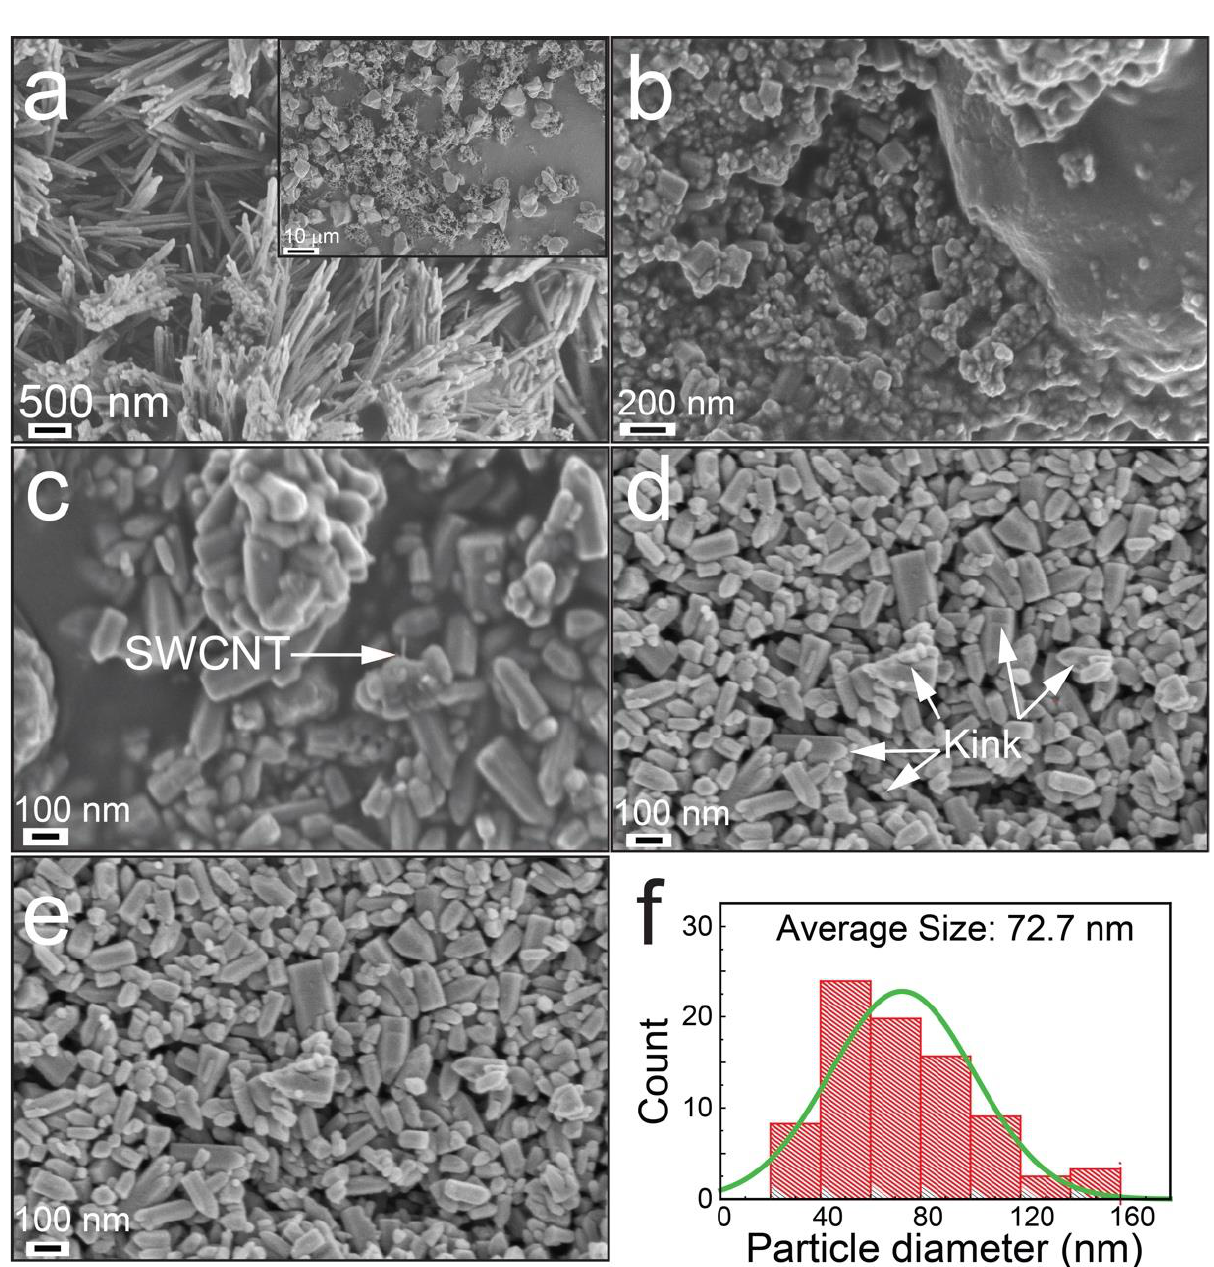
Figure 2. FE-SEM images: ( a ) pristine ZnO, ( b ) ZSC1, and ( c ) ZSC2. ( d ) Micrograph showing defects developed on the surface of the ZSC3 heteronanocomposite. ( e ) Micrograph of ZSC3. ( f ) Histogram of the particle size distribution of the ZSC3 heteronanocomposite. The inset in ( a ) shows the FE-SEM image of pristine monoclinic CuO nanocrystals.